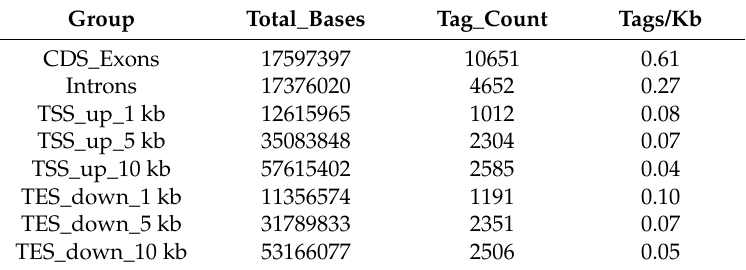
Table 4. Analysis of 5-hmC enrichment over D. pulex functional elements. Tags denote number of locations where 5-hmC was found to be enriched. Tags/Kb—density of peaks per kilobase of analyzed sequence in a given genomic element. CDS: coding sequence site; TES: transcription end site; TSS: transcription start site. Group Total_Bases Tag_Count Tags/Kb CDS_Exons 17597397 10651 0.61 Introns 17376020